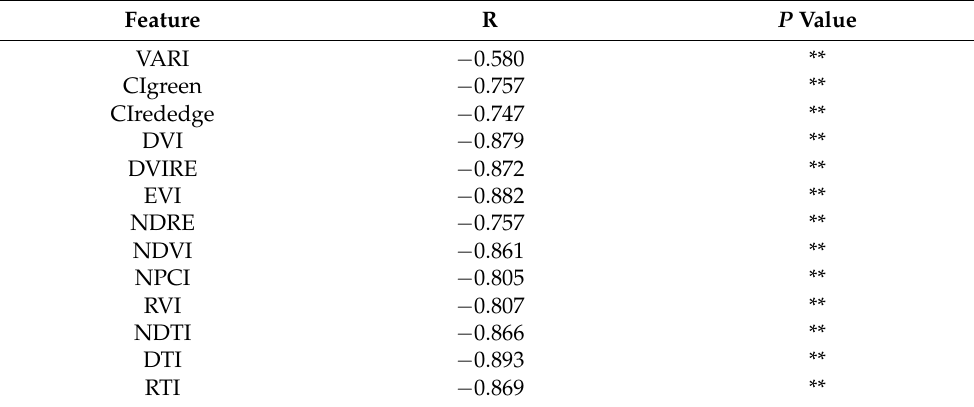
Table 3. Correlation analysis result between different modeling feature and wheat FHB. Feature R P Value